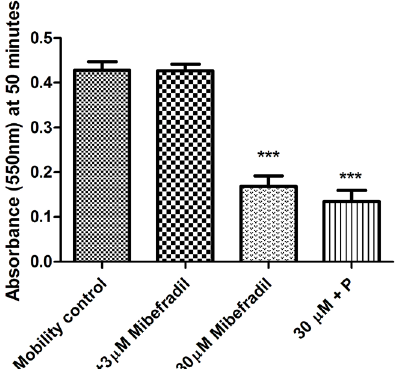
Figure 5. Mibefradil inhibits the mobility of capacitated boar sperm. Under control conditions sperm penetrate the Accudenz solution with a Km = 23.0 ± 4.9 min (mobility control, 19 replicates). Mibefradil (30 m M) containing Accudenz solution significantly inhibits cell mobility from 20 minutes onwards (P<0.05 at 20 minutes, 21 replicates). Data are analysed using ANOVA followed by Tukeys post- hoc test. Data sets are an average of 4 ejaculates from different boars with pooled replicates as indicated. Positive and negative control data sets are an average of 4 ejaculates measured in quadruplicate.